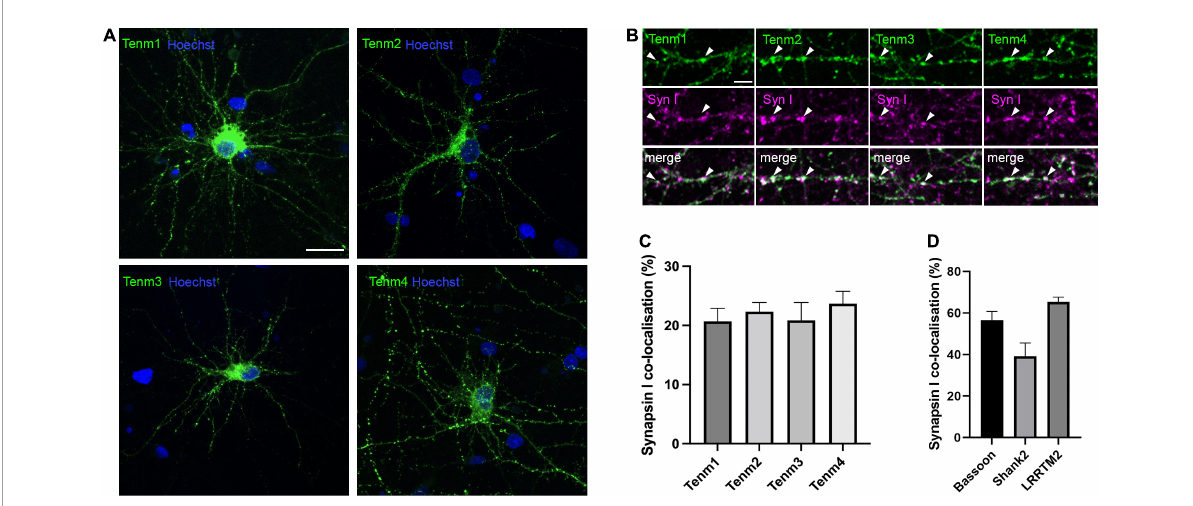
FIGURE1 Teneurins form discrete puncta, some of which are localised to synaptic sites. (A) EGFP-tagged teneurin paralogues overexpressed in rat cortical cultures are unevenly distributed across the membrane. (B) Synapsin I immunostaining in dissociated cortical cells overexpressing EGFP-tagged teneurin show partial co-localisation of teneurin puncta with synapsin I (two examples marked with arrow heads for each teneurin member). (C) Similar levels of partial co-localisation are observed between all four teneurin paralogues with synapsin I. (D) Synapsin I co-localisation for bona fide synaptic proteins bassoon (56%), shank (38%), and LRRTM2 (65%). Data represents mean ± SE based on samples with at least 14 cells/condition pooled from a least three different experiments. One-way ANOVA with Dunnett’s multiple comparison test was performed between all paralogues ( p < 0.05). Scale bar, 20 µ m (A) , 5 µ m (B)